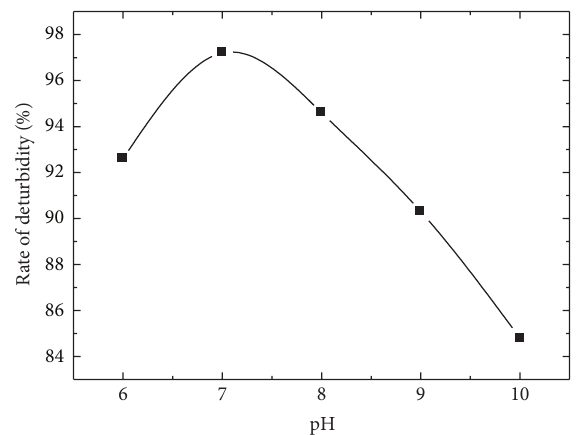
Table 3: The influence of additives on coagulation behaviors of BTA while PAC content was 15% (200NTU diatomite suspension).